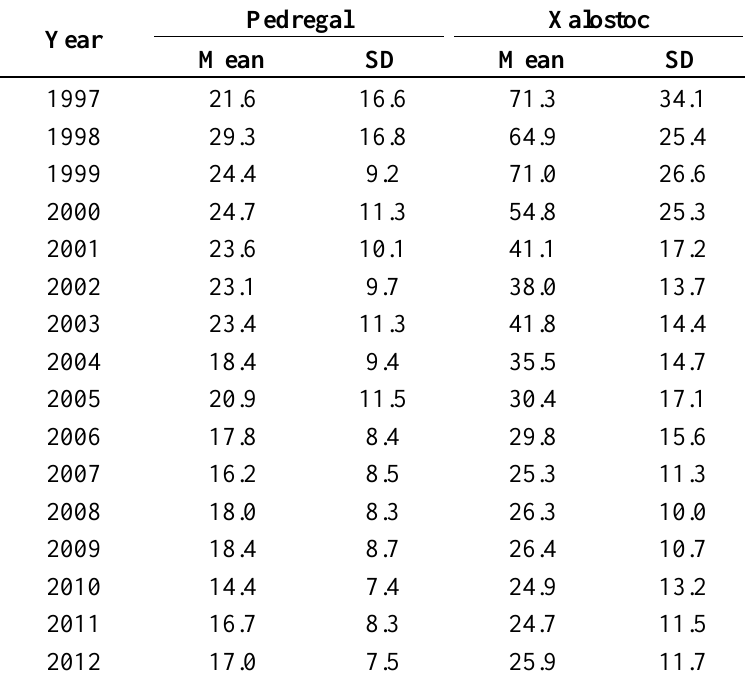
Table 1. PM annual concentrations in µg/m 3 for the North vs. the South selected 2.5 monitoring stations. The differences are significant with a p <